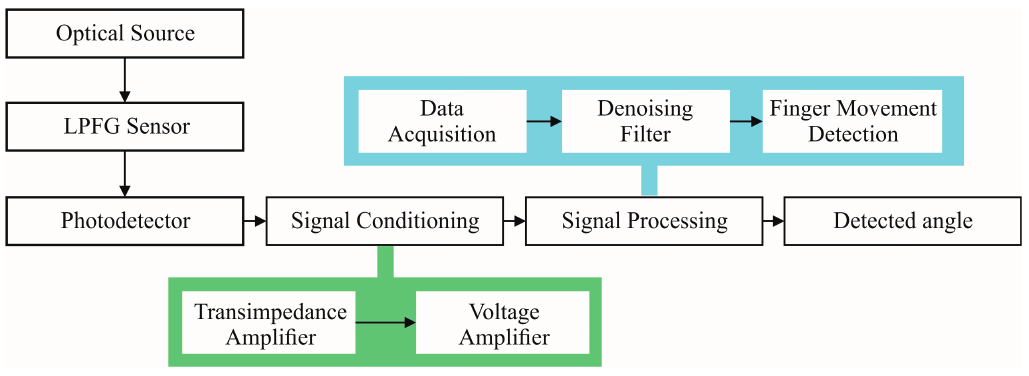
Figure 2. Proposed System block